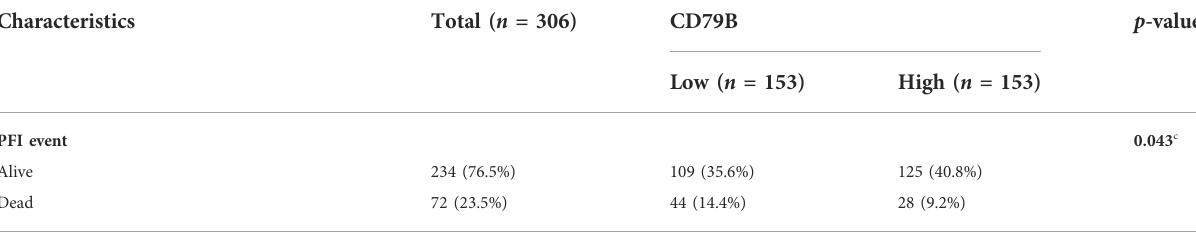
TABLE 1 ( Continued ) Relationship between CD79B expression in cervical cancer and clinicopathological